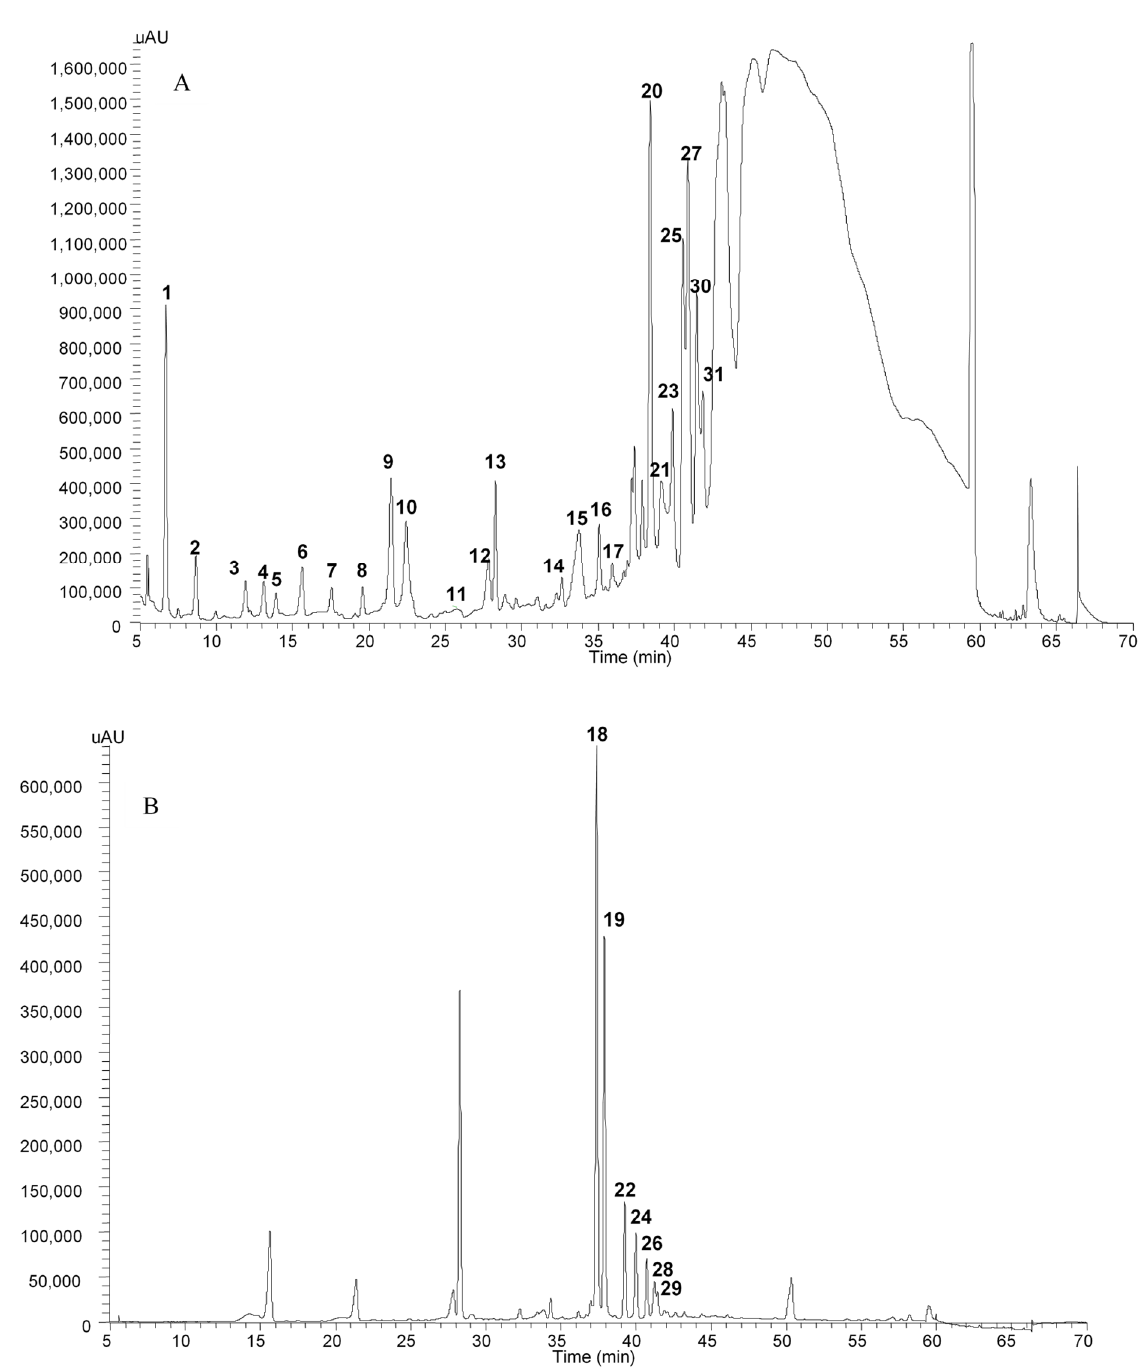
Figure 1. HPLC chromatogram identifying phenolic extracts from the peel of cv. ‘Cogshall’ mango measured at 280 nm ( A ) and 370 nm ( B ).